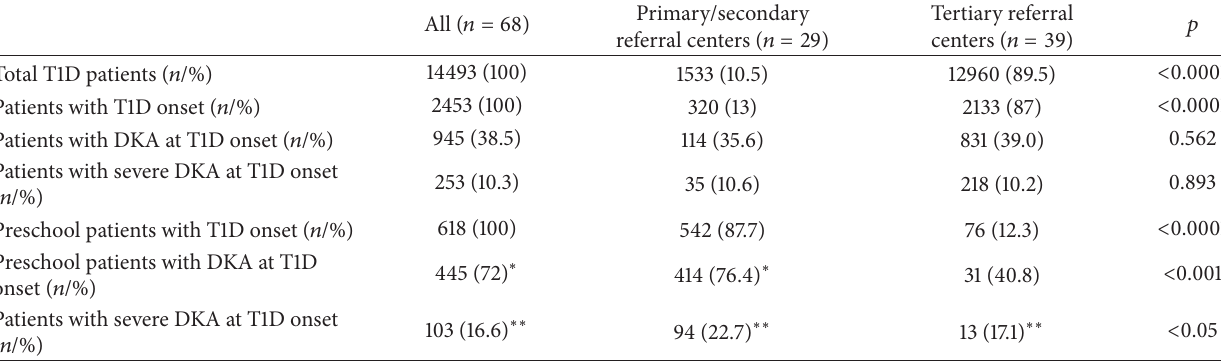
Patients with T1D onset ( 𝑛